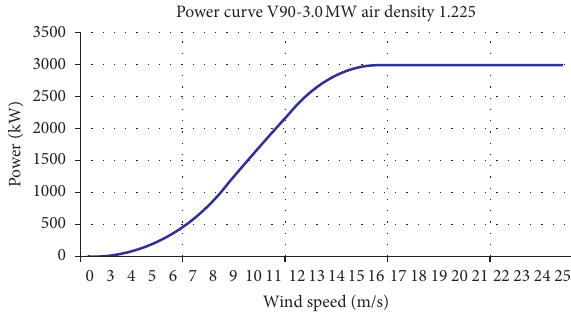
Figure 4: Power curve for Vestas V90-3.0 MW, 60Hz, 106.7. Table 1: The results of the Lagrange multiplier test.